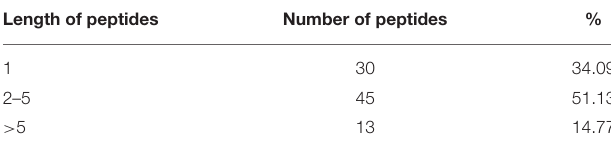
TABLE 7 | In silico hydrolysis of the lectin protein. Length of